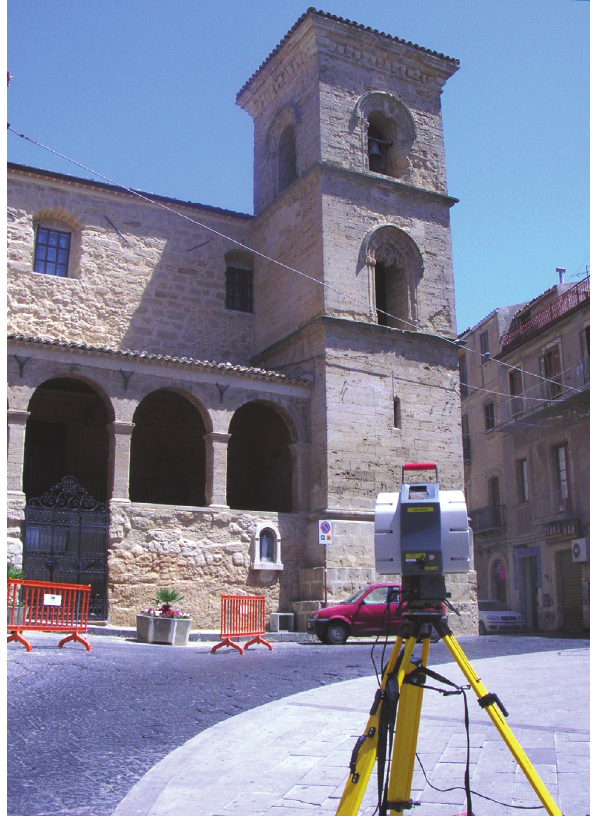
Figure 3. In situ survey